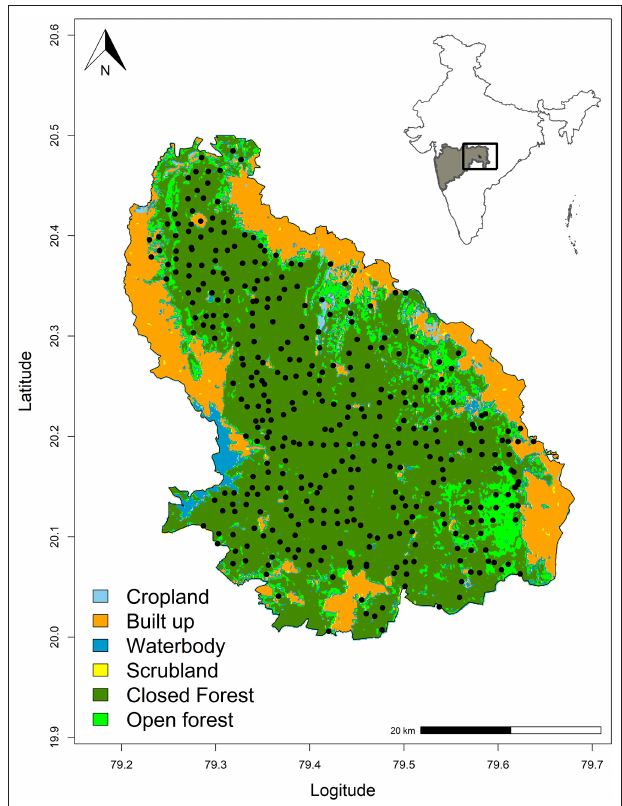
FIGURE 1 | Study area showing camera trap locations in Tadoba-Andhari Tiger Reserve (TATR). Inset: Location of the study area in India. The map shows forested areas (in dark green) and villages (in yellow) within the boundary of TATR. Forest cover used in the map was obtained from Forest Survey of India